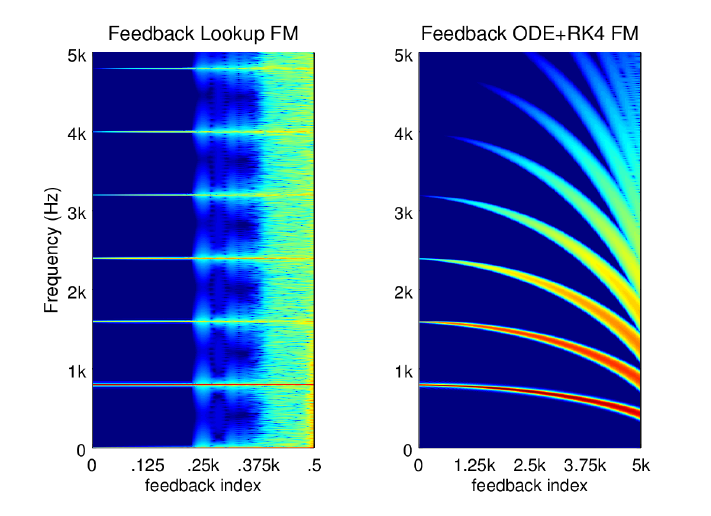
Figure 6. Sweeping the modulation index in feedback